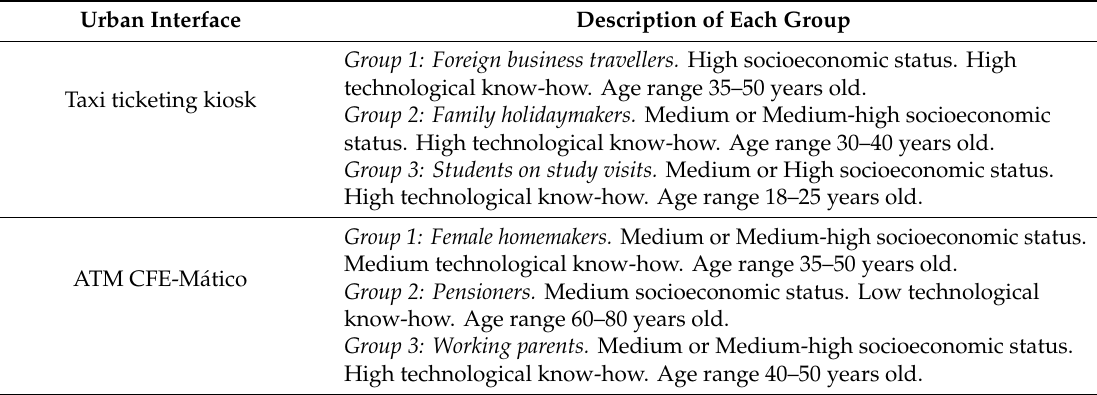
Table 4. Characteristics of Groups Observed using each Interface.